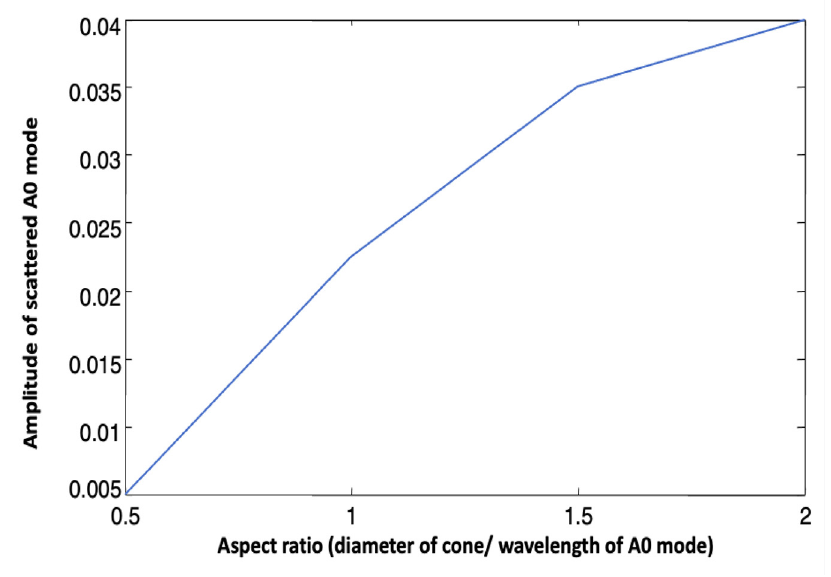
Figure 16. Variation of amplitude of scattered A 0 mode with respect to aspect ratio (2 r/ λ ) towards 45° direction.